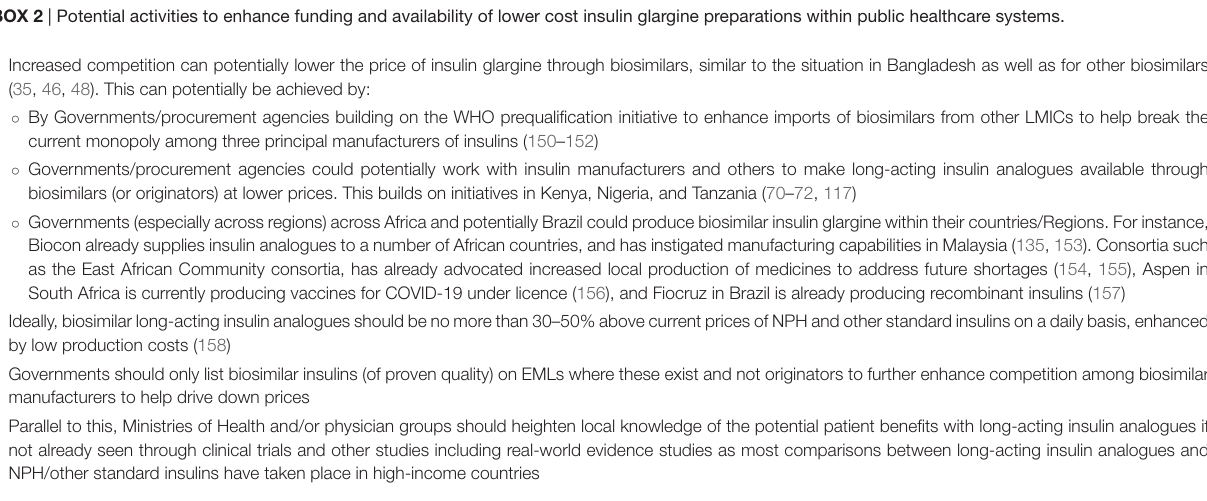
launch (Bio vs. Originator) %